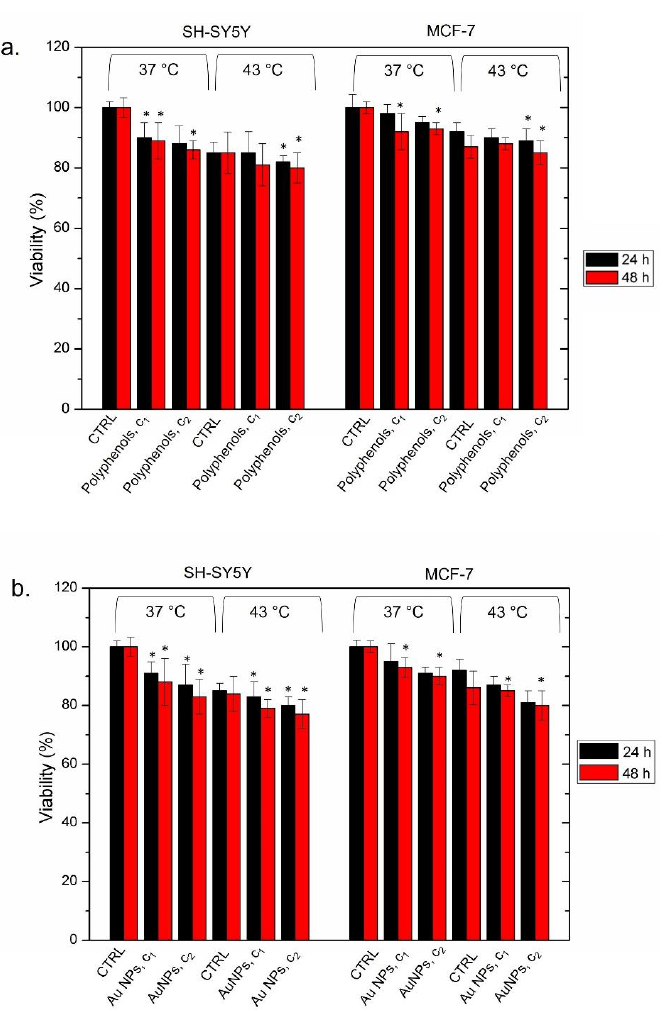
Figure 7. Viability assay (WST-8) of SH-SY5Y and MCF-7 cell lines after 24 h and 48 h of exposure Table 1. and c2) of polyphenols ( a ) and Au NPs ( b ) at 37 °C and 43 °C, following the procedure described in the section, Materials (ph. 2.10). The viability of NP-treated cells was normalized to non-treated control cells. As a positive control (P), the cells were incubated with 5% DMSO (data not shown). The data reported as the mean ± SD from three independent experiments and they are considered statistically significant, compared with the control ( n = 8), with a p value < 0.05 (<0.05